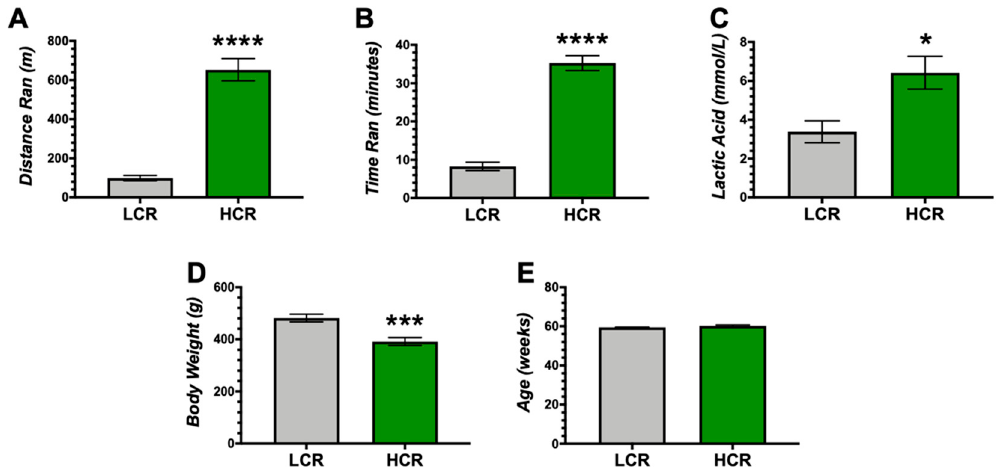
Figure 1. Phenotypic differences between low capacity running (LCR) and high capacity running (HCR) rats. ( A ) Distance ran to exhaustion. ( B ) Time ran to exhaustion. ( C ) Blood lactic acid levels. ( D ) Body Weight. ( E ) Age of rats. * p < 0.05 as compared to LCR rats. *** p < 0.01 as compared to LCR rats. **** p < 0.001 as compared to LCR rats. n = 9/group.